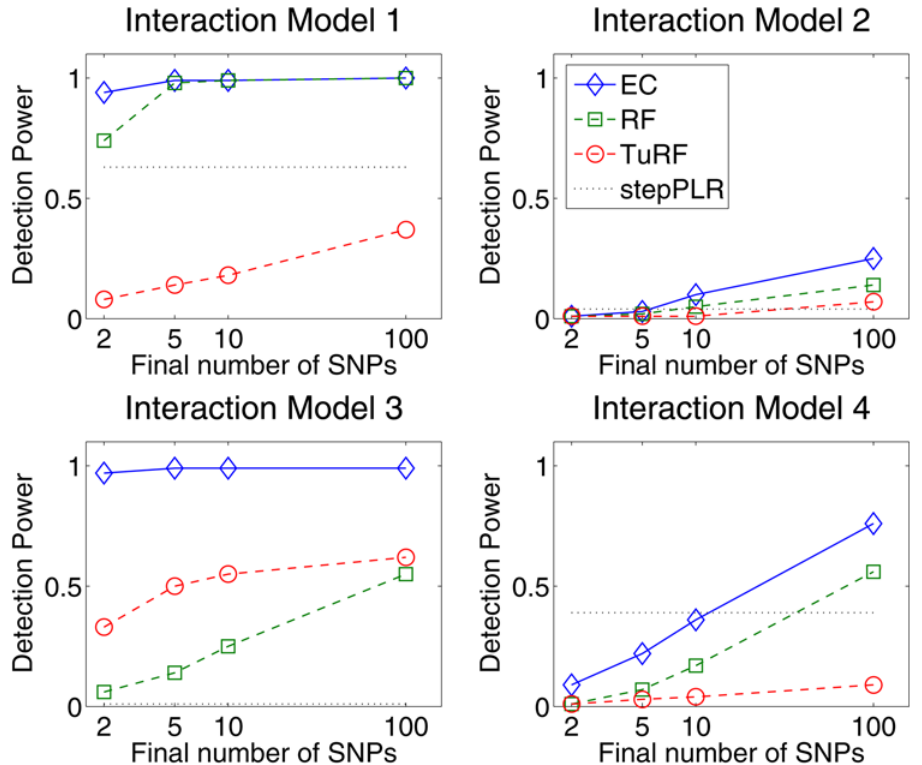
Figure 2. Detection power comparison of forward stepwise penalized logistic regression (stepPLR), Random Forests (RF), tuned Relief-F (TuRF) and Evaporative Cooling (EC) filter for 100 simulated replicates of each of the models defined in Figure 1 using 500 cases and 500 controls and 1500 total SNPs. Detection power is defined as the percentage of replicates for which both causal SNPs are found above the cutoff in the filter’s rank list. The power is plotted as a function of the rank-list cutoff on a log scale, from the top 2 up to the top 100 final SNPs. EC, RF and TuRF results are sorted by importance score. Detection was counted for stepPLR if both causal SNPs had nonzero coefficients in the LR models.